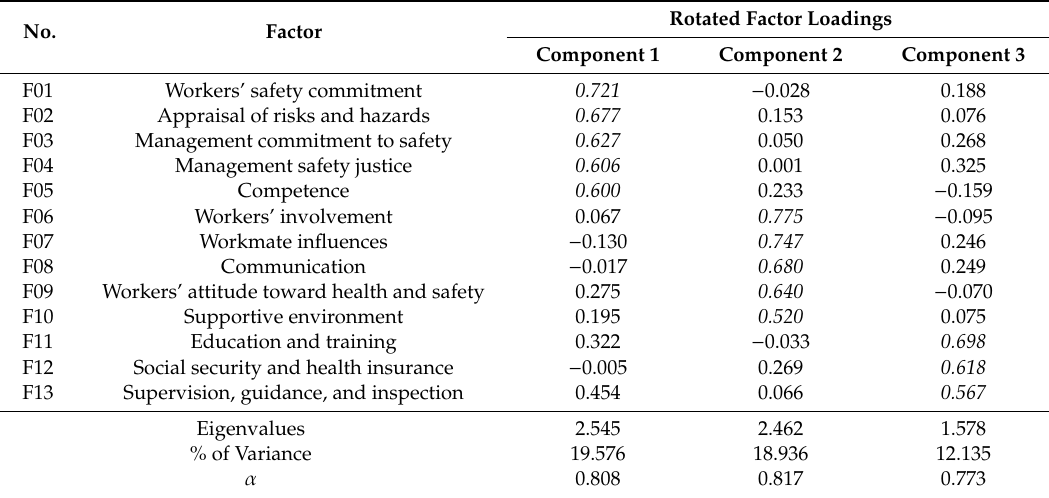
Table 3. Summary of exploratory factor analysis results for the determinants of safety climate evaluation ( n =